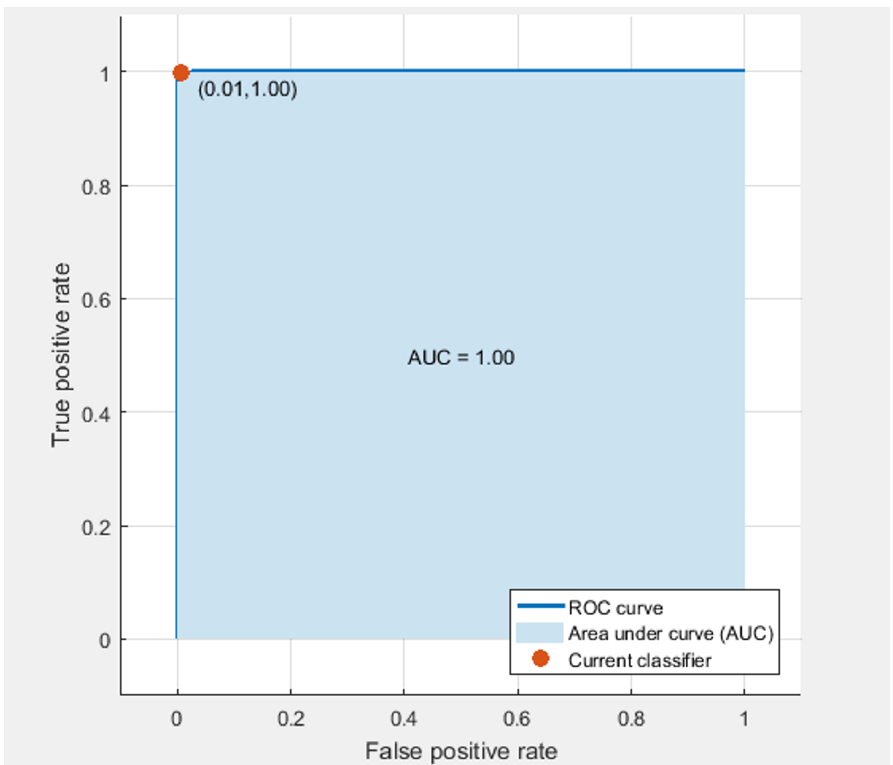
Figure 21. ROC of ACC and EMG measured from biceps brachii muscle bagged tree classifier.